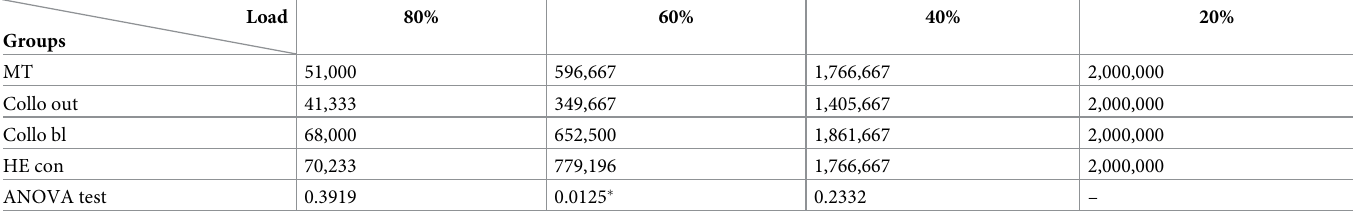
Table 2. Mean and statistical comparison of cycles supported by the samples of each group in the 4 intensities of forces calculated on the value of maximum resis- tance obtained in the quasi-static test. Load Groups